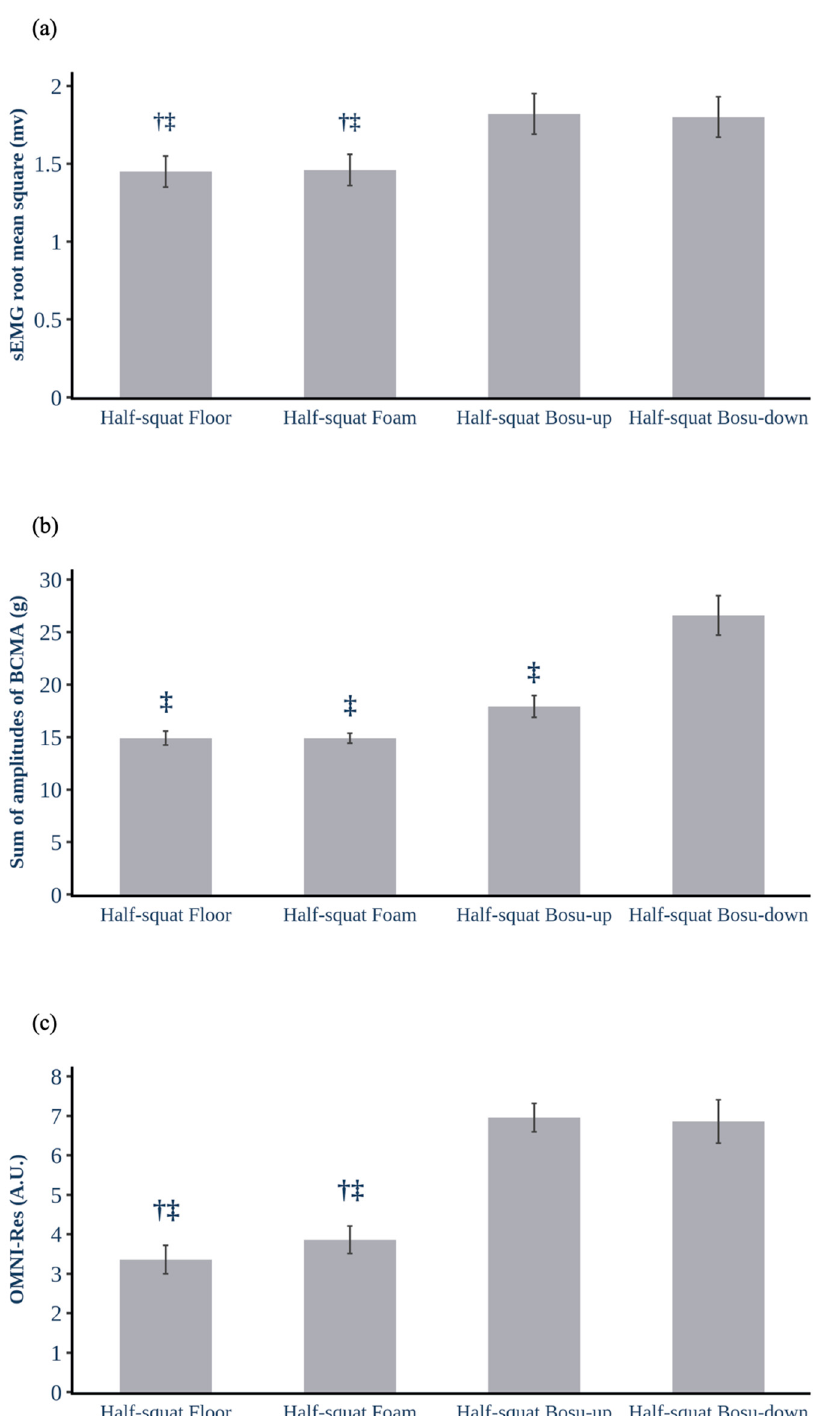
Figure 3. Comparison of the collected data under half-squat conditions: ( a ) global activity § , ( b ) body centre of mass acceleration, and ( c ) OMNI-Perceived Exertion Scale for Resistance Exercise (OMNI-Res). Each bar represents the mean, and the error bar represents the standard error of the mean (SE). § = Sum of the activity of the vastus medialis, lateralis and biceps femoris; sEMG = surface electromyography; mV = microvolts; BCMA = body centre of mass acceleration; A.U. = Arbitrary units; †Significantly different from half-squat BOSU-up; ‡Significantly different from half-squat BOSU-down.